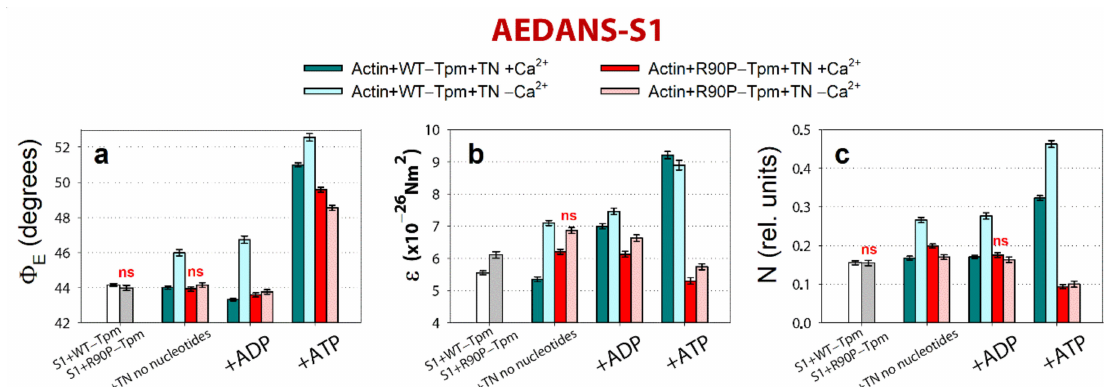
Figure 8. The effect of troponin and Ca 2+ on the values of Φ E ( a ), ε ( b ), and N ( c ) of the polarized fluorescence of N- (iodoacetaminoethyl)-1-naphthyl-amine-5-sulfonic acid (1,5-IAEDANS) bound to S1 (AEDANS-S1), in the presence of WT-Tpm or R90P-Tpm, revealed in ghost fibers under conditions simulating the sequential steps of the actomyosin ATPase cycle. The data represent the mean values for 5–7 fibers for each experimental condition. The Φ E , ε , and N values in the absence and in the presence of TN, Ca 2+ , and nucleotides are significantly altered by the R90P substitution in Tpm ( p < 0.05). Statistically insignificant differences in the values of Φ E , ε , and N between the WT and mutant Tpms are marked by the symbol “ns”. Error bars indicate ±